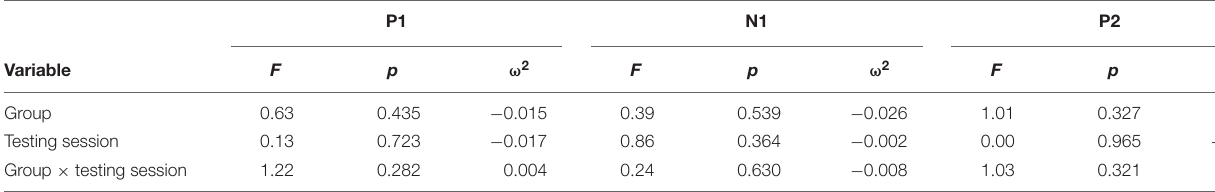
TABLE 8 | Results of P1-N1-P2 Amplitudes at FCz Repeated Measures ANOVA.